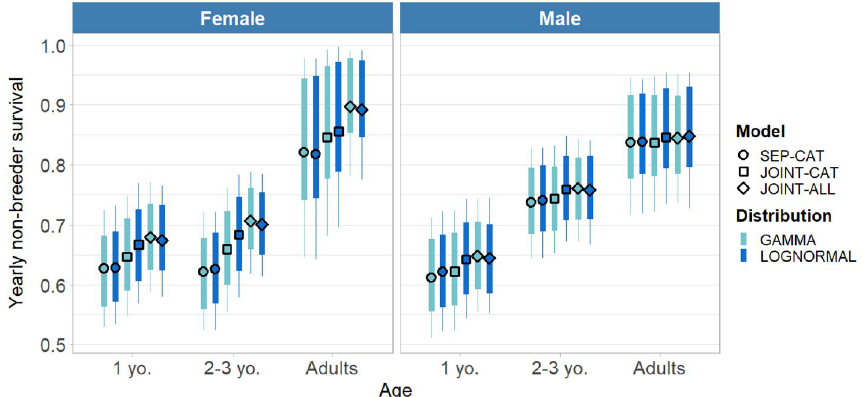
Figure 5. Non-breeder survival by model, age, sex, and distribution. Circles and squares indicate median values. Thick lines indicate the 66% HPDI and fine lines show the 89%